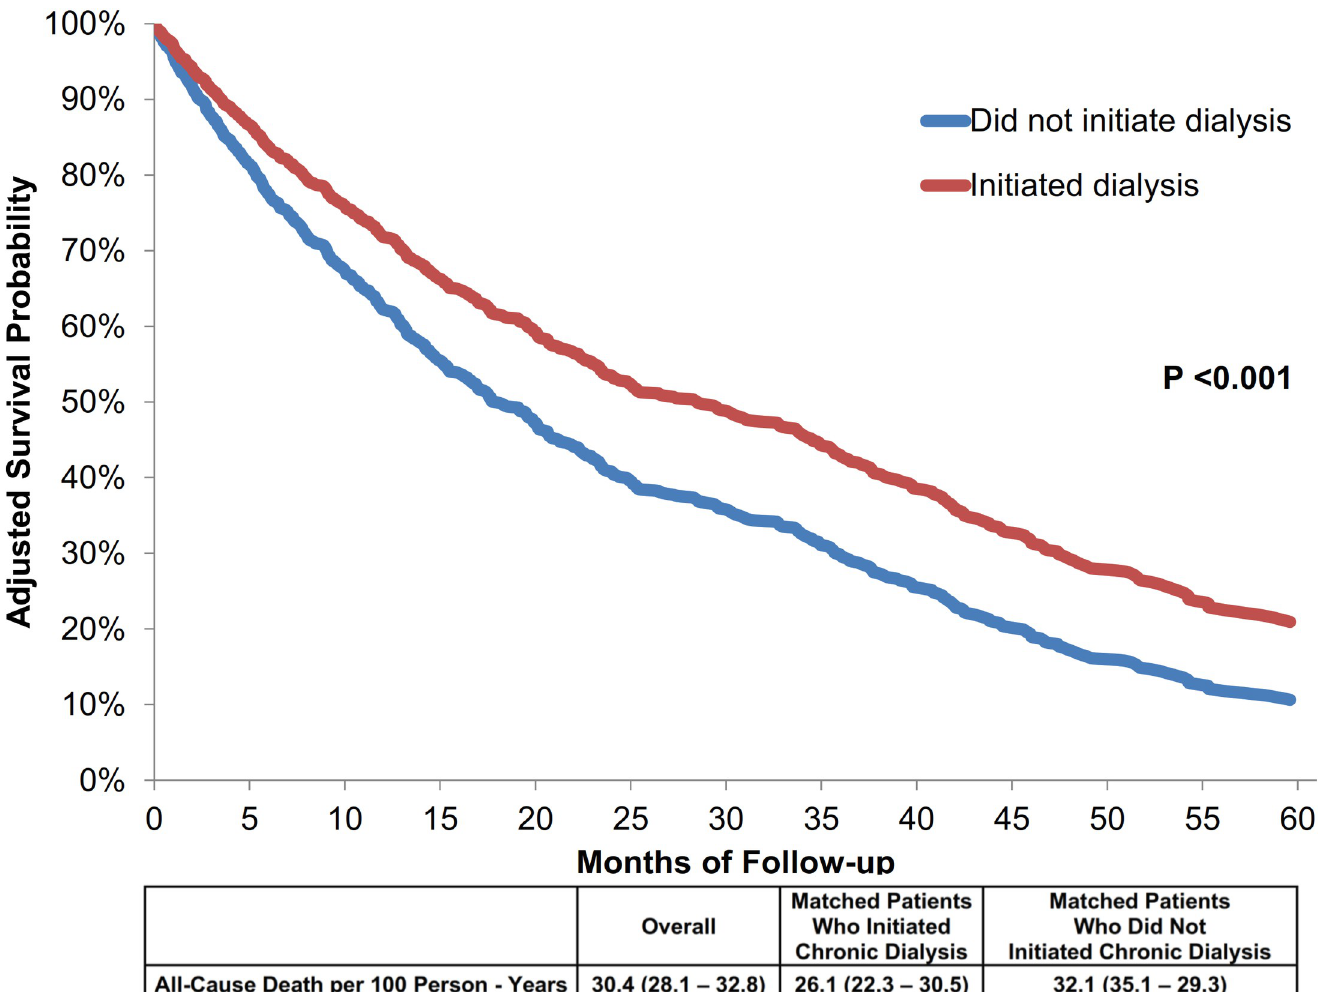
Fig 2. Rate of death and adjusted survival curves of 1,295 matched adults aged � 70 years old with chronic heart failure and advanced chronic kidney disease between 2008 and 2012. Survival probabilities were calculated for patients with the following characteristics based on the distribution of the overall cohort: 79 years old; male; non-Hispanic white race; with dementia; body mass index < 25 kg/m 2 ; systolic blood presuure < 130 mmHg; hemoglobin � 12 g/L; potassium 3.5–4.9 mmol/L; sodium 130–139 mmol/L; urine protein dipstick of +1 or greater; receiving diuretic, and calcium channel; and not receiving